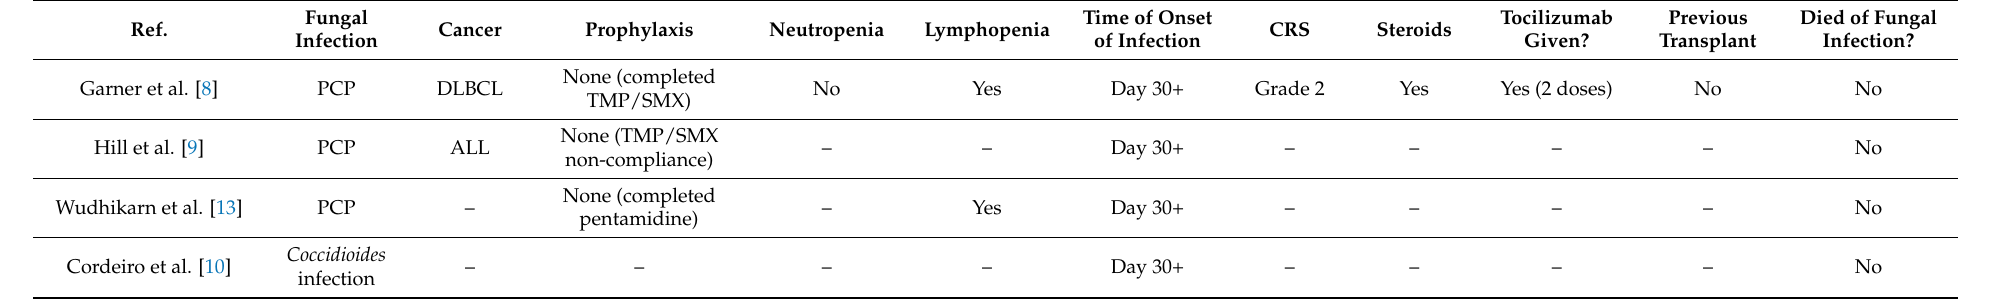
Table 3. Published reports of other invasive fungal infections following CAR-T-cell therapy. Neutropenia defined as absolute neutrophil count <500 cells/ µ L. Lymphopenia defined